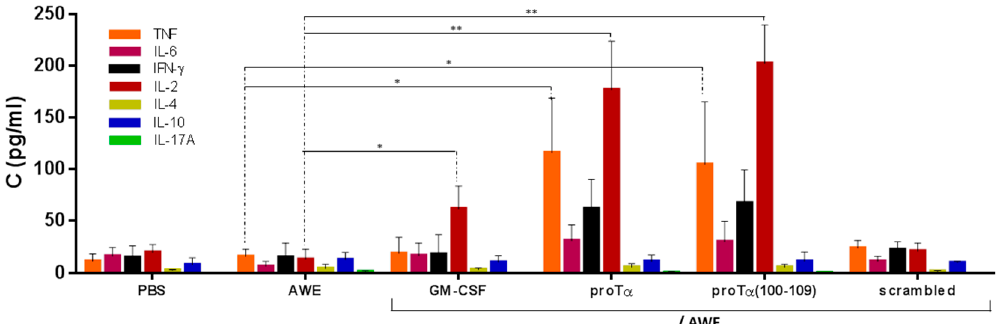
Figure 5. Proinflammatory and Th1-type cytokine levels were higher in serum of mice treated in vivo with proT α / AWE and proT α (100–109) / AWE. Mouse sera collected on day 34 were analyzed by flow cytometry using Cytometric Bead Array (CBA). Mean concentration of each cytokine (in pg / mL) ± SD from five mice / group is shown. * p < 0.05 and ** p < 0.01 compared to AWE.